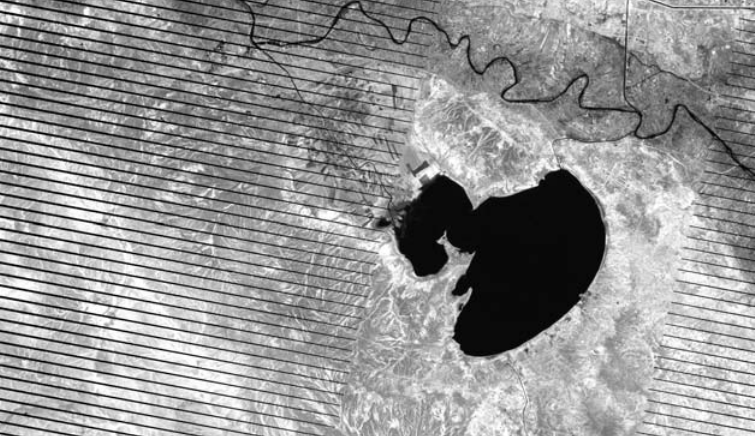
Fig.2: The image contains a scan line corrector (SLC) taken from USGS website (https://earthexplorer.usgs.gov/). The date of this picture is 12/11/2018